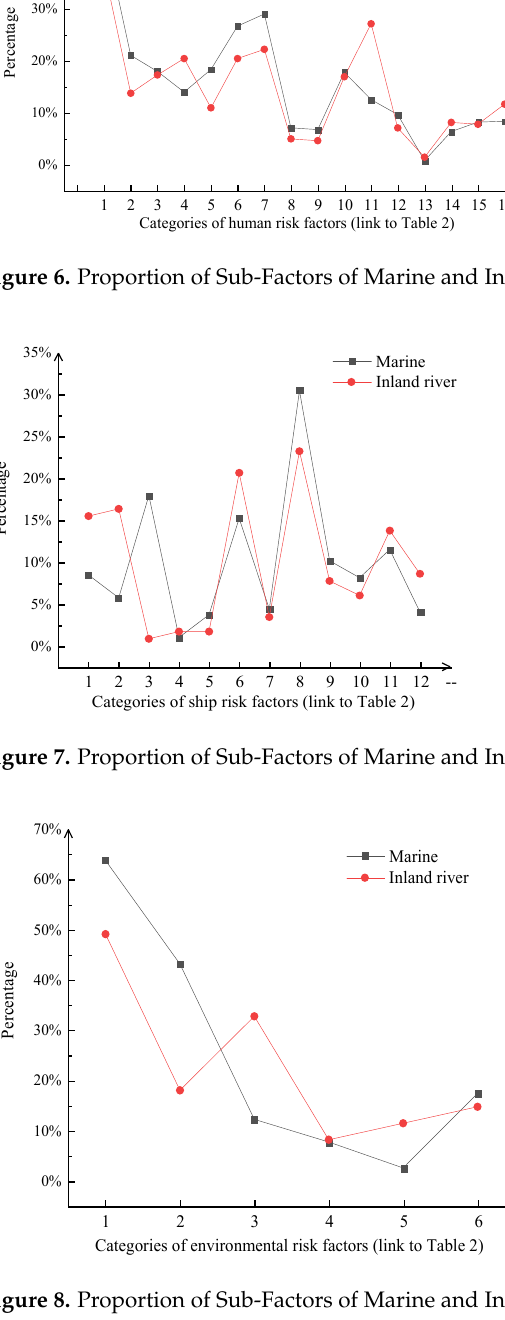
Figure 8. Proportion of Sub-Factors of Marine and Inland River Environmental Factors.